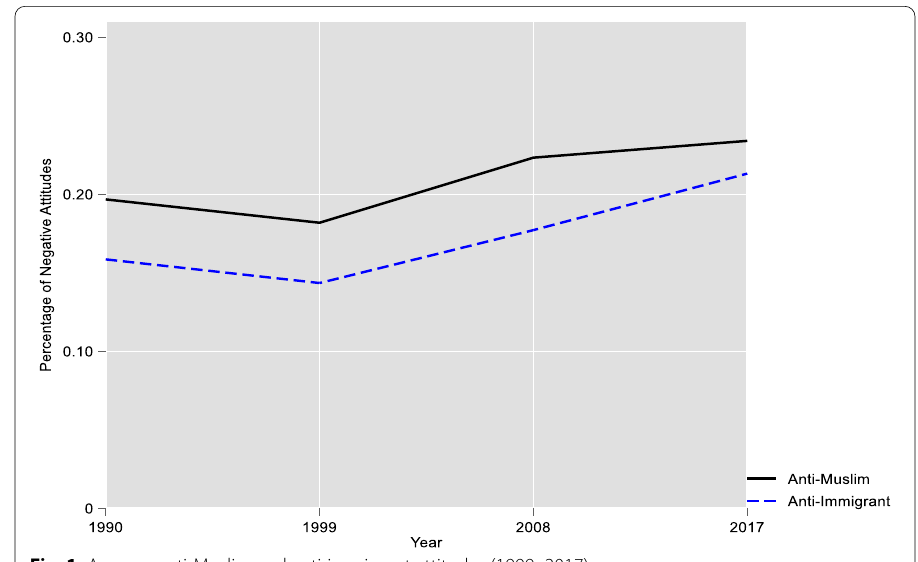
Fig. 1 Average anti-Muslim and anti-immigrant attitudes